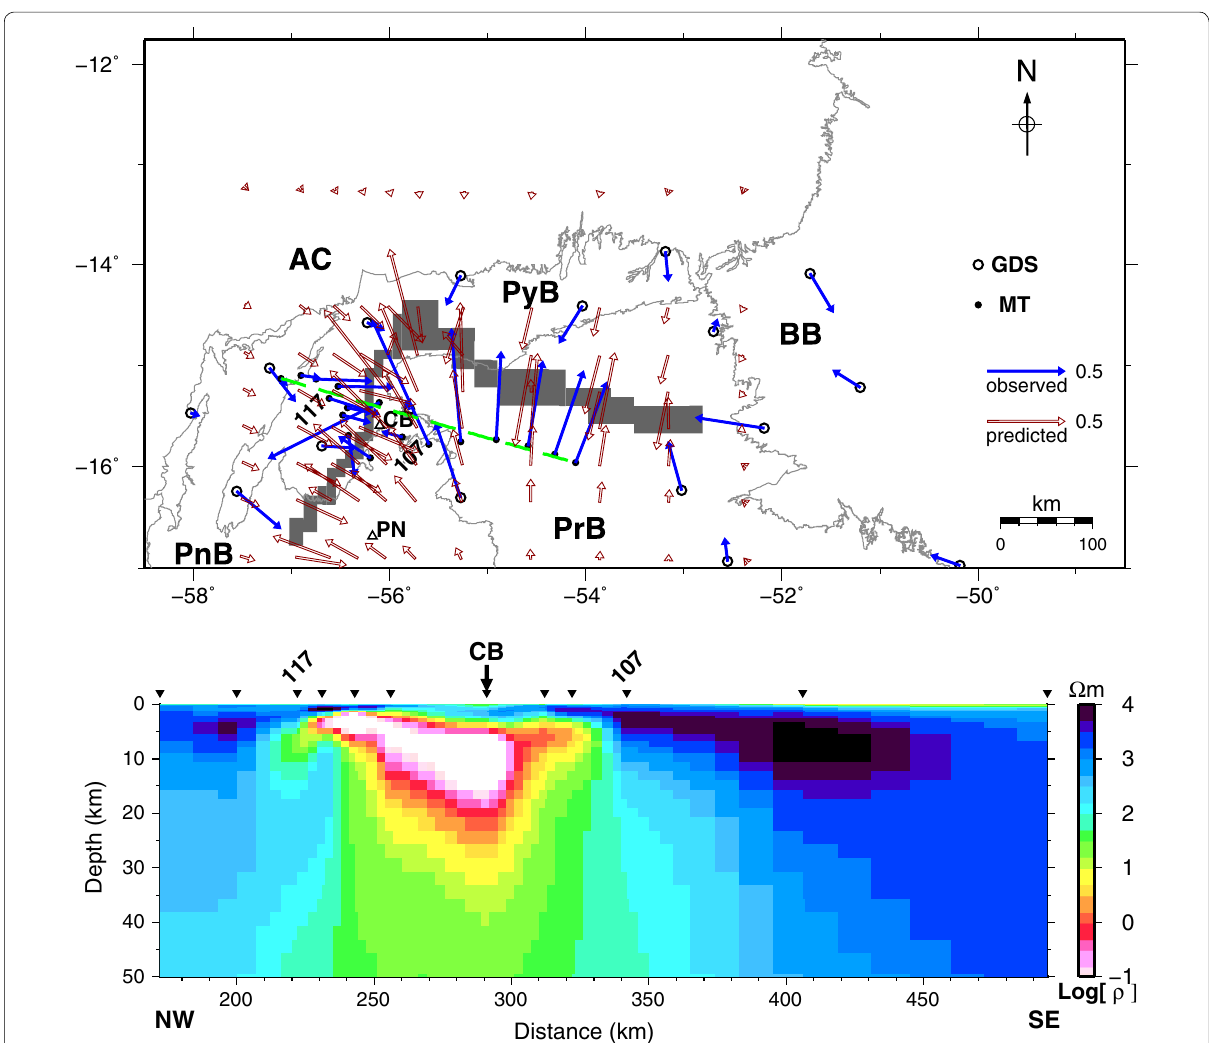
Fig. 5 Electromagnetic induction results from NW Brazil (Bologna et al. 2014). ( Top ) Observed and calculated real induction arrows for a period of 320 s, together with the PACA conductor at a depth of 20 km ( dark area ) as mapped by GDS modeling. Green dashed line is the location of the inverted MT profile. The main geologic structures are: Amazonian Craton (AC), Paraguay belt (PyB), Brasília belt (BB), Pantanal Basin (PnB) and Paraná basin (PrB). Location of geomagnetic stations (CB and PN) is also included. ( Bottom ) 2-D resistivity model across PACA obtained by inversion of MT data. Projection of the CB magnetic station on the MT profile is